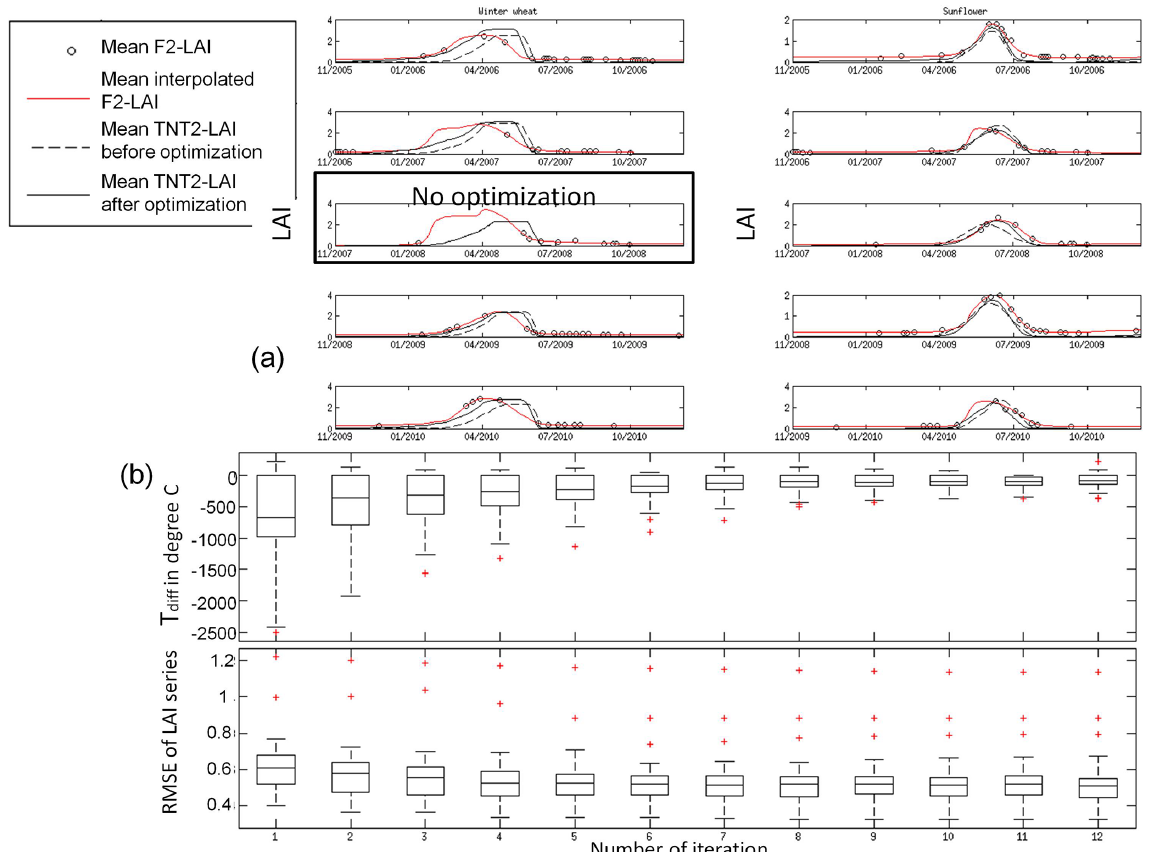
Figure 5. (a) Average LAI computed at the crop-field level for winter wheat (left) and sunflower (right) for each year of simulation (lines). Simulated LAIs before and after the optimization process are shown in dashed and full black lines, respectively. Average crop-field level LAIs retrieved from F2 images are represented by black circles and the average interpolations from these images are shown by full red lines. (b) Evolution of T diff in degree days and RMSE found for each crop as a function of the number of optimization process iterations. The first and third quartile and the median of T diff and RMSE for each crop field are shown. Red crosses stand for